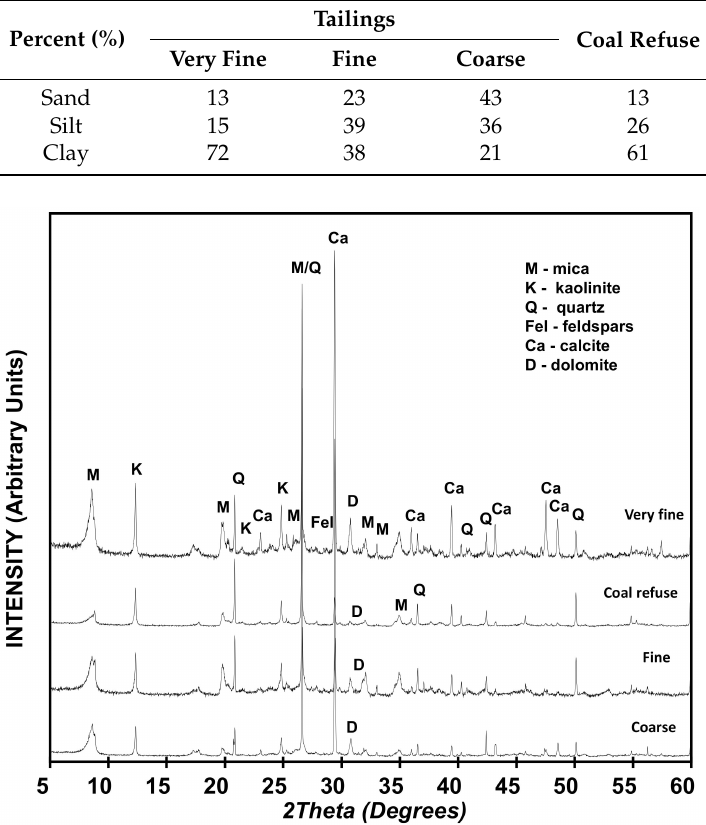
Figure 3. Diffraction spectra of the raw tailings samples.